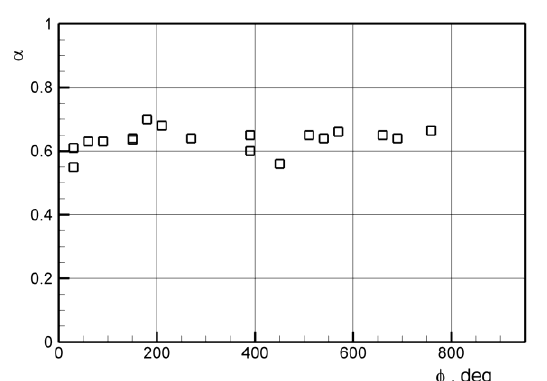
Fig. 8 Coefficient α in Vatistas vortex model as a function of vortex age.